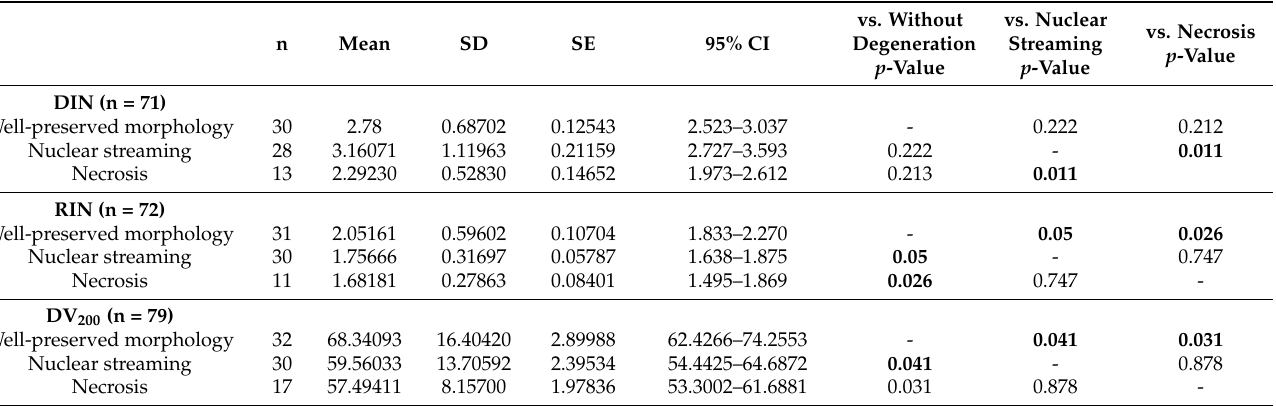
Table 1. Comparison of DNA integrity number, RNA integrity number, and DV 200 between the three histological